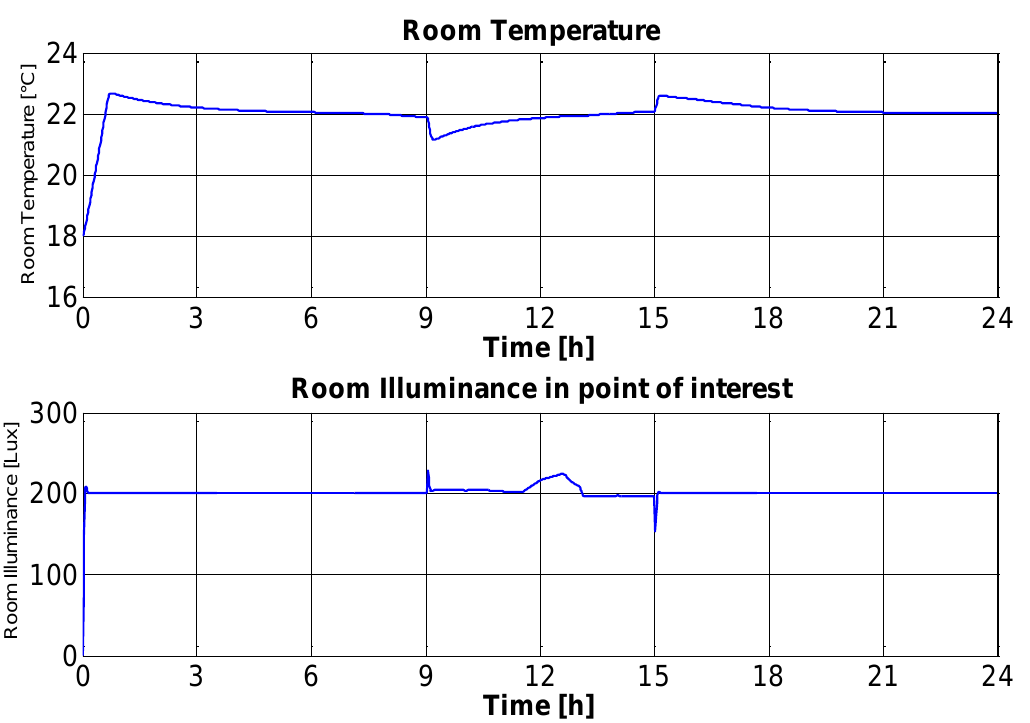
Figure 28. Control results (first scenario, initial control system, Comfort policy): room temperature and room illuminance (CVs).